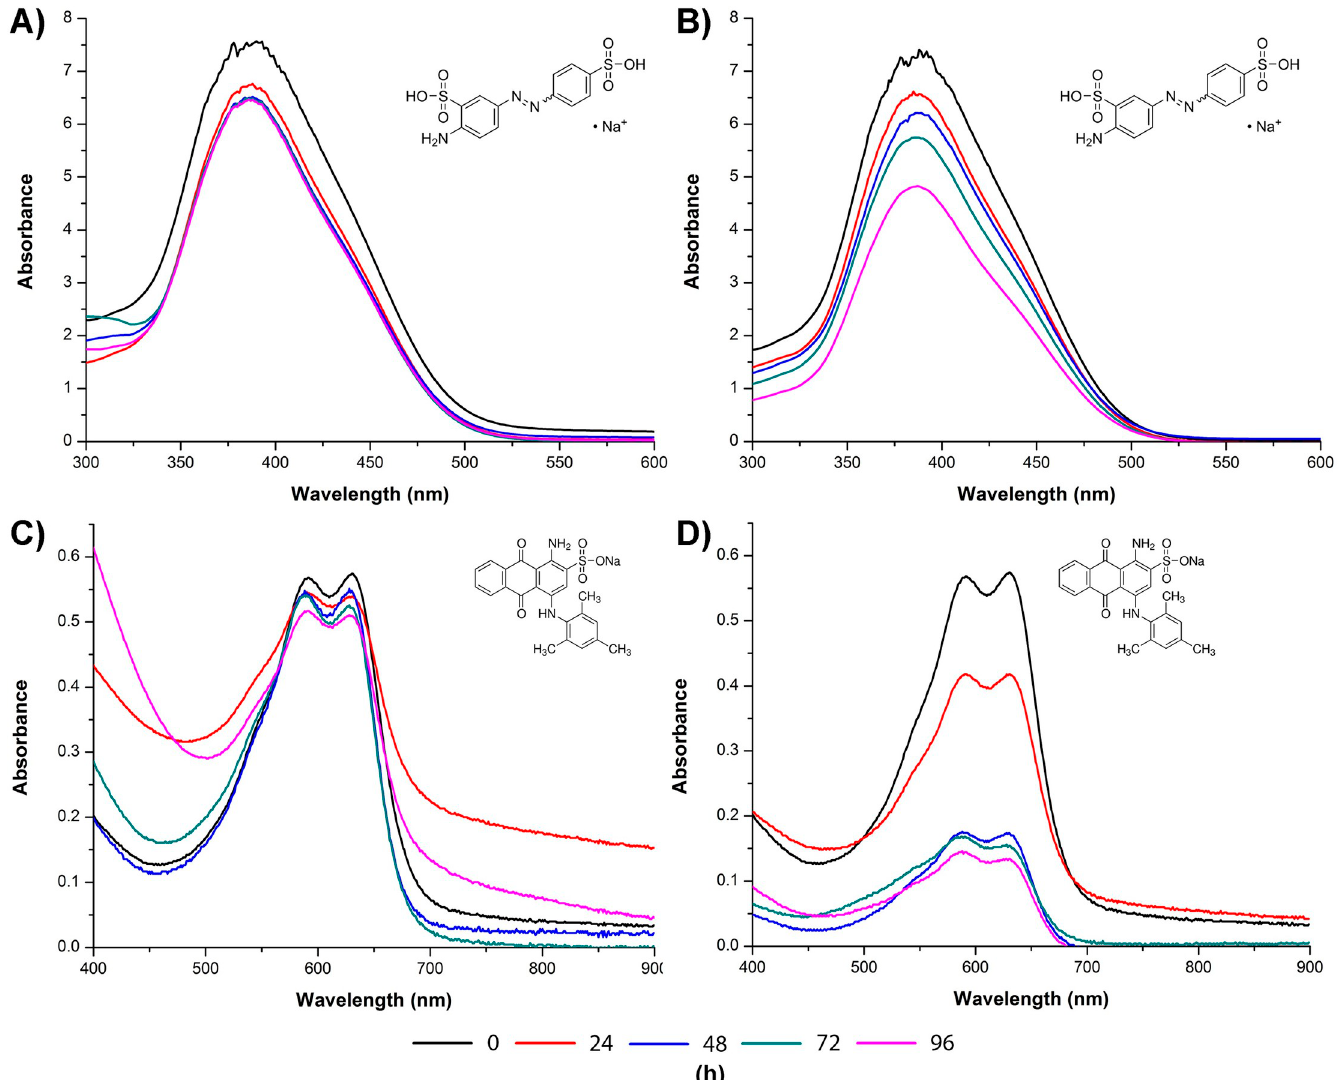
Fig 6. UV/Vis spectral changes of dyes. The UV/Vis spectra variation for the AYG and AB129 dyes was monitored during the T . atroviride culture-course, conducted at 28˚C for 96 h. (A) WT strain in AYG, (B) TaDyP1_7 strain in AYG, (C) WT strain in AB129 and (D) TaDyP1_7strain in AB129. Maximum absorbance for AYG at 390 nm and AB129 recorded at 630 nm. The inset structural formula in A-B is AYG and AB129 in C-D.